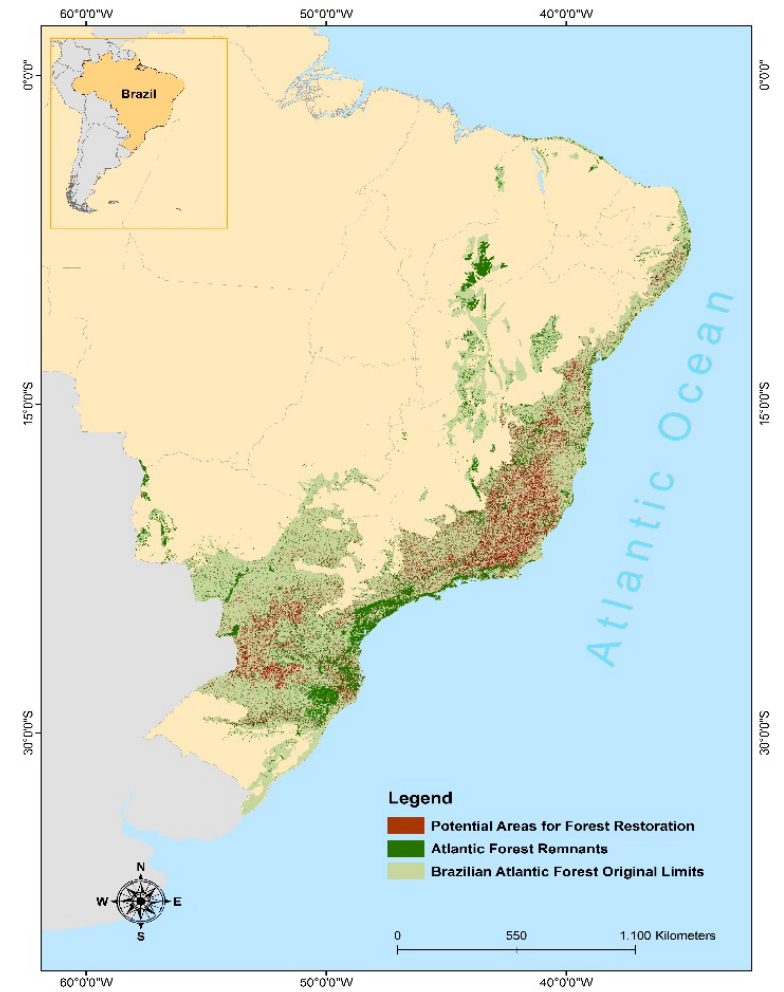
Figure 1. Fifteen million ha of potential areas for forest restoration mapped in the Atlantic Forest by the Atlantic Forest Restoration Pact in